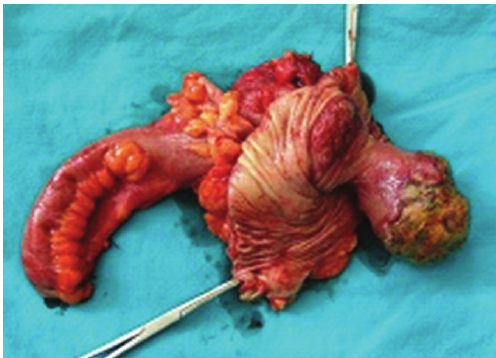
Figure 3: Macroscopic picture of the resected specimen showing the presence of a round pedunculated cecal polypoid tumor with ulcerated overlying